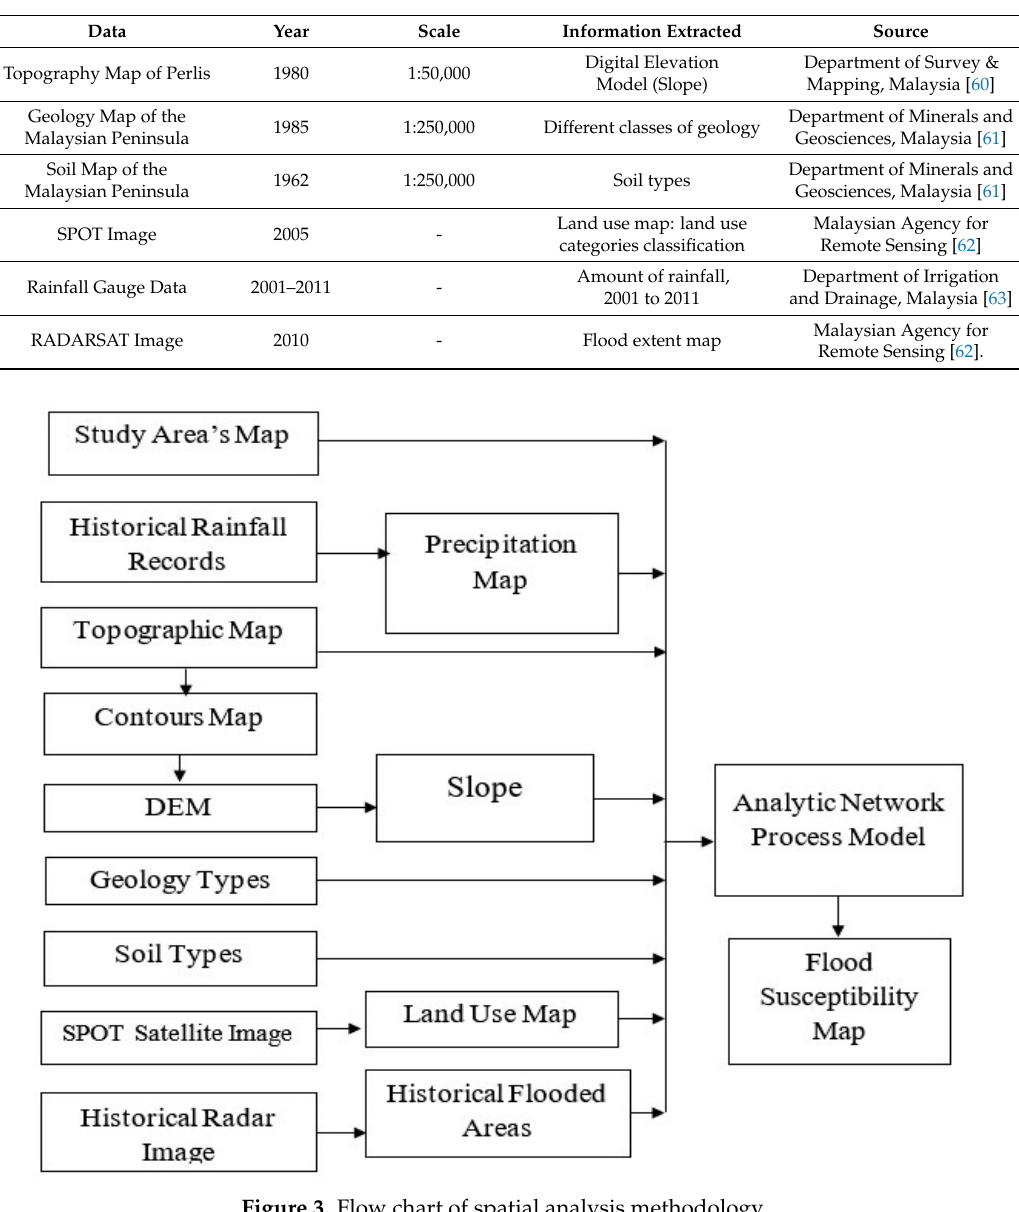
Figure 3. Flow chart of spatial analysis methodology.